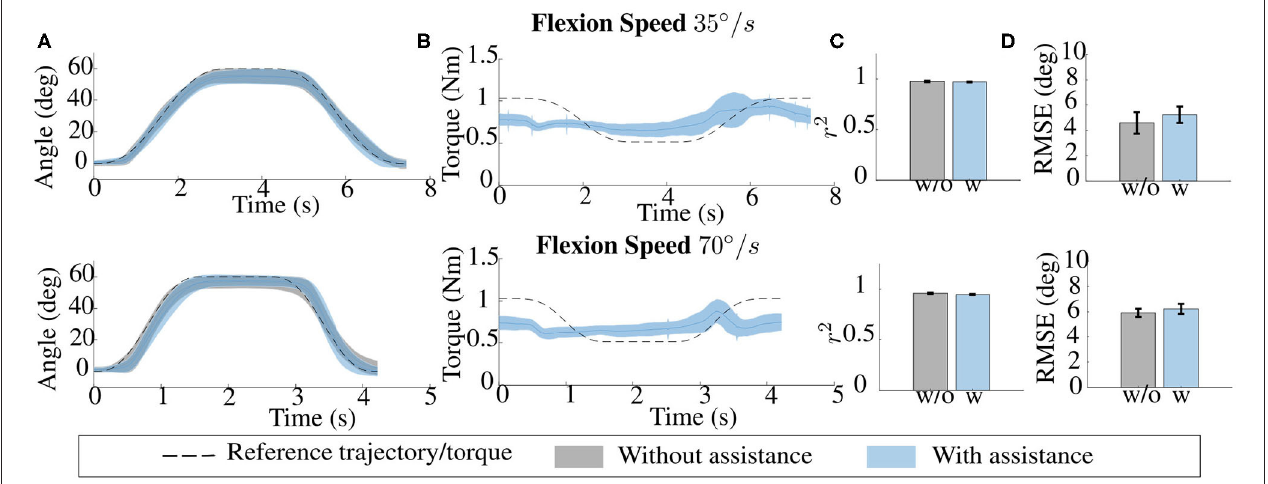
FIGURE 9 | (A) Trajectories for the unpowered and powered conditions, averaged over repetitions, for one subject and at the two tested velocities (from top to bottom: 35 and 70 deg/s); as the velocity increases, the accuracy of the powered condition decreases. (B) The reference gravity torque and the assistance torque averaged over repetitions. (C) Average accuracy, measured through the coefficient of determination, r 2 , between the reference and measured trajectory of the wrist in the unpowered and powered condition. The overall mean, averaged over subjects, indicate that the assistance from the exosuit reduces a subject’s capacity to follow a reference motion. Still, the absolute value of accuracy remain relatively high r 2 = 0.971 ± 0.003 for 35 ◦ / s and r 2 = 0.947 ± 0.005 for 70 ◦ / s . The same effect can be seen by analyzing in (D) the root mean square (RMS) error between the reference and measured trajectory of the wrist in the two conditions. In this case, the root mean square error (RMSE) slightly increased in the powered condition (with no significant statistical difference).